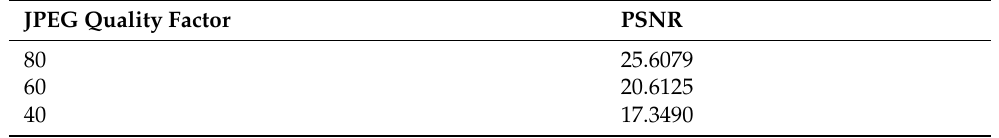
Figure 15. Reconstructed Lena from a JPEG compressed cipher image: ( a ) quality factor 80, ( b ) quality factor 60, and ( c ) quality factor 40. Table 10. PSNR values between the plain image Lena and the reconstructed images after JPEG compression with different quality